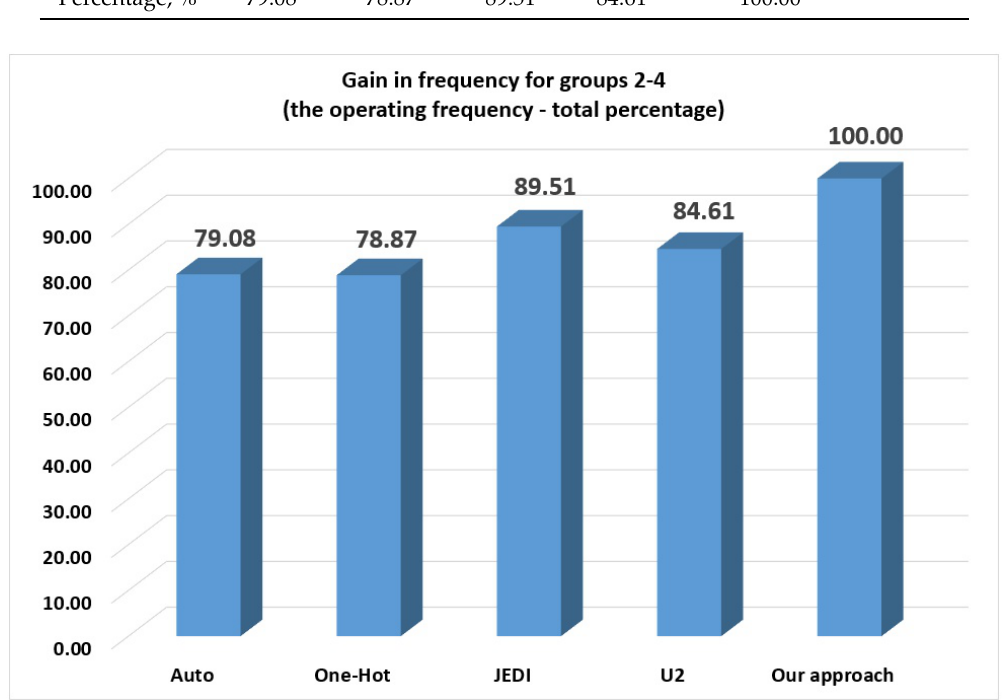
Figure 16. Gain in frequency for groups 2–4 (the operating frequency—total